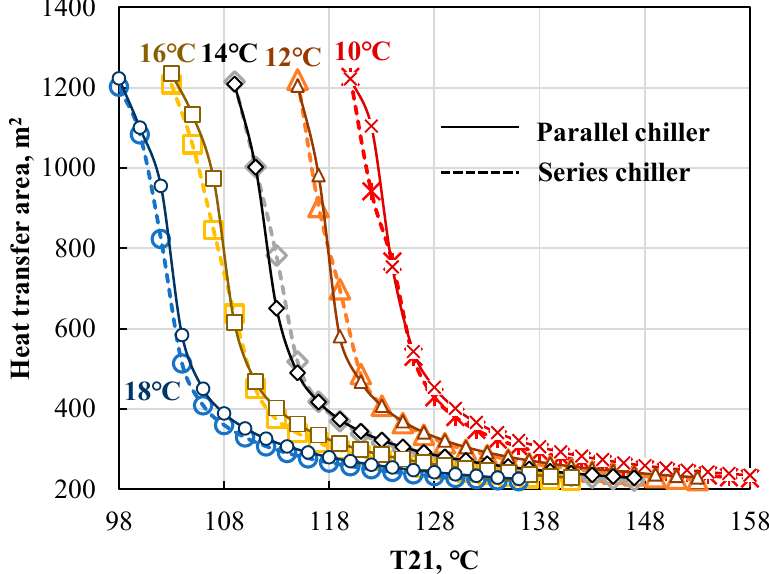
Figure 7. Variation of heat-transfer areas with the two types of absorption chillers as function of chilled water temperature and steam temperature (T21).